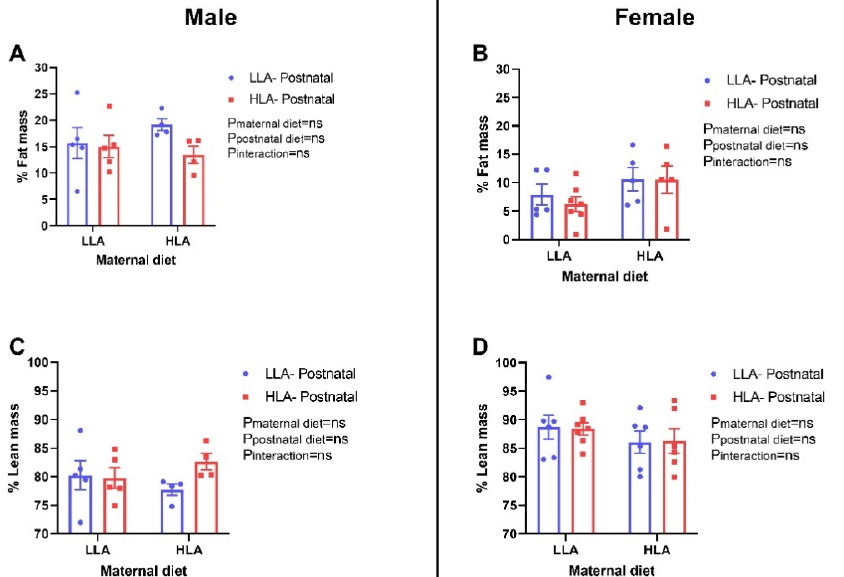
Figure 1. Effect of a maternal and postnatal diet high in linoleic acid on fat mass and lean mass in adult offspring. Data are presented as mean ± standard error of the mean (SEM). Two-way ANOVA was performed for statistical analysis with maternal diet and postnatal diet as two factors. n = 4–7. LLA: low linoleic acid; HLA: high linoleic acid; PN: postnatal. A : % Fat mass males, B : % Fat mass females, C : % Lean mass males, D : % Lean mass females